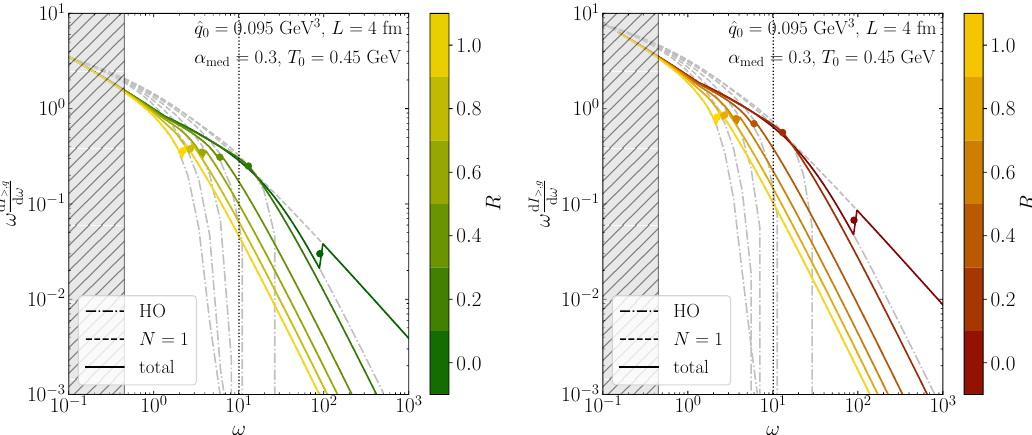
Figure 1 . The out of cone emission spectrum, matched at NNLO for quarks (left) and gluons (right) from eq. (2.24) for different cone sizes. The dash-dotted (dashed) grey lines are the HO ( N = 1 ) spectra, the bullets show the matching points ω below in which emitted gluons thermalize during the broadening. The hatched band shows where ω < T 0 , considered and neglected as